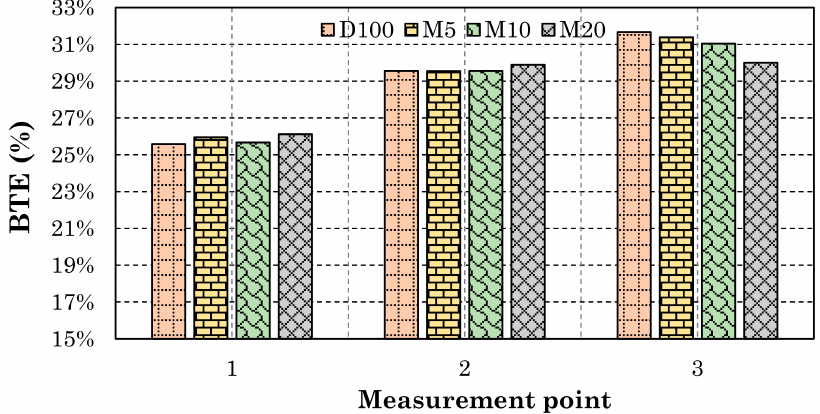
Figure 8. Brake thermal efficiency of all test fuels at the measurement points.